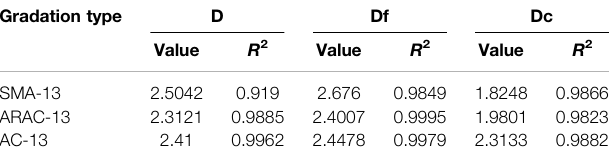
TABLE 6 | Calculation results of the fractal dimension of three gradations.